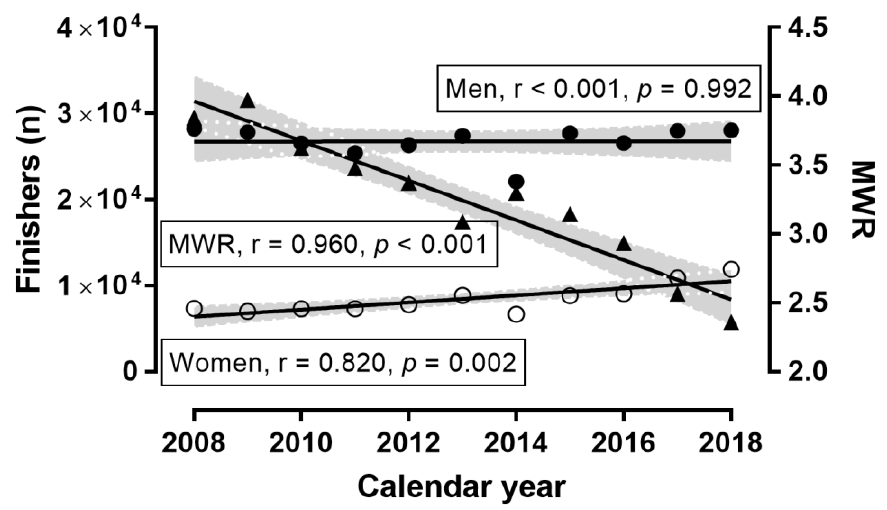
Figure 1. Number of finishers by sex and calendar year. Note: MWR = men-to-women ratio; shadowed areas denote 95% confidence intervals; = women, ⚫ = men. (cid:35)